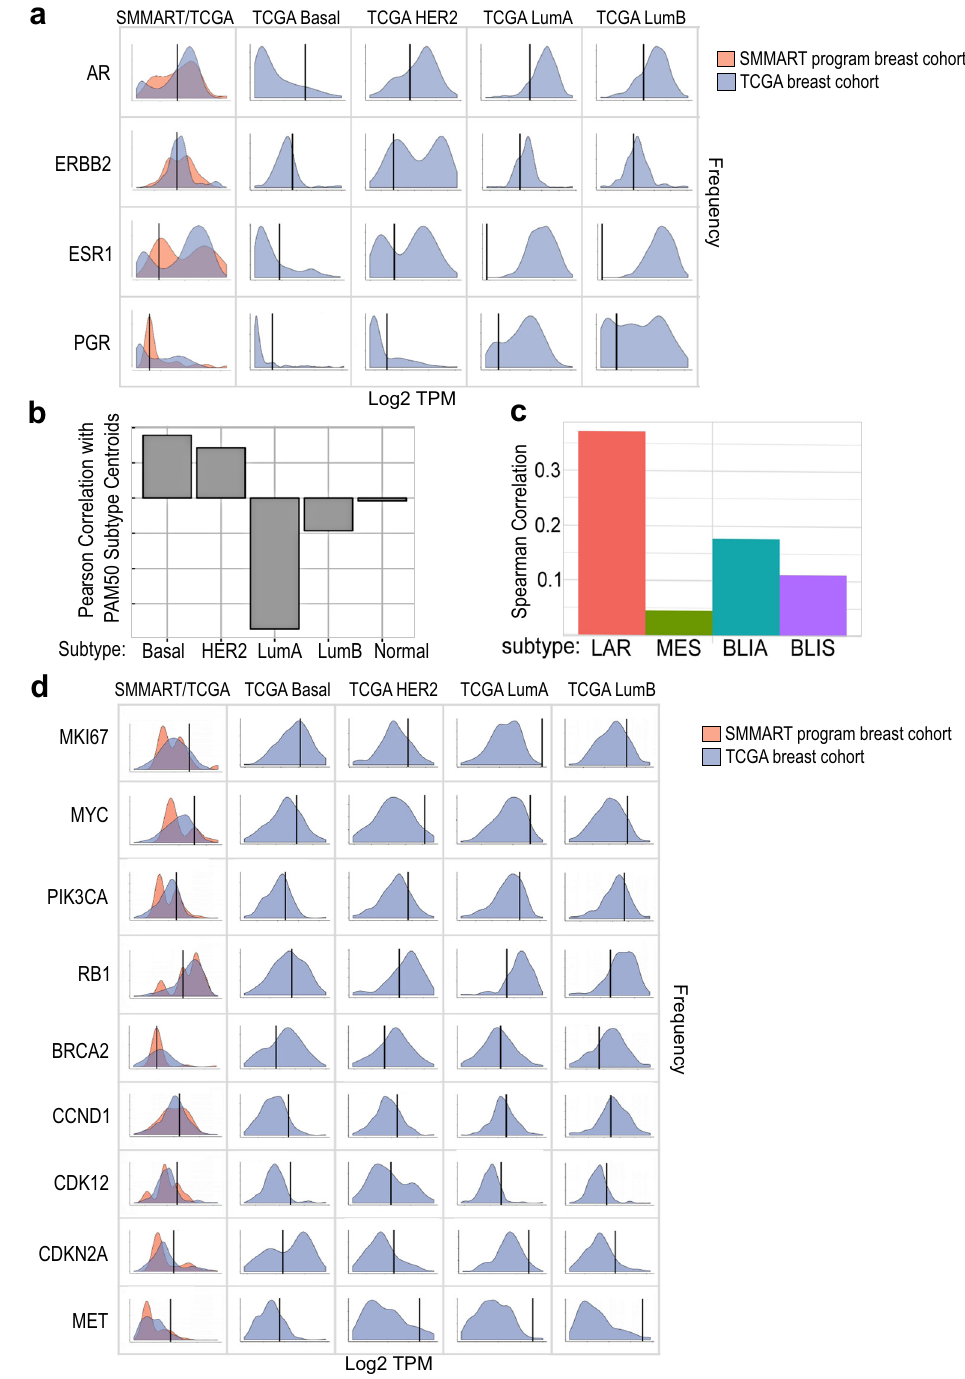
Fig. 4 RNA pro fi ling analysis of Study biopsy #2 showing intrinsic subtyping and gene expression of hormone receptors and identi fi ed copy alterations. a Hormone receptor gene expression: distribution of batch corrected gene expression values, z -scaled within each cohort, fi ltered by subtype, and depicted as a density histogram. Y -axis shows the frequency, X -axis represents the log transformed transcripts per million (TPM), mean centered and scaled within each cohort: TCGA Breast Cancer cohort ( n = 1227), in blue, and a SMMART-program metastatic breast cancer cohort ( n = 40), in orange. Black line marks the patient ’ s RNA expression for ERBB2 (HER2), ESR1 (ER), PGR (PR), and AR . b PAM50 intrinsic subtyping analysis of RNA expression related to fi ve breast cancer subtypes: Basal, HER2, Luminal A (LumA), Luminal B (LumB), and Normal. Y -axis is the Spearman Correlation. c TNBC-speci fi c intrinsic subtyping: analysis of RNA expression that identi fi es four basal subtypes: basal-like immune-activated (BLIA), basal-like immunosuppressed (BLIS), mesenchymal (MES) and luminal androgen receptor (LAR). Y -axis is the Spearman Correlation. d Additional RNA expression pro fi les of genes found to be altered by genomic or proteomic assays, processed and displayed as in ( a